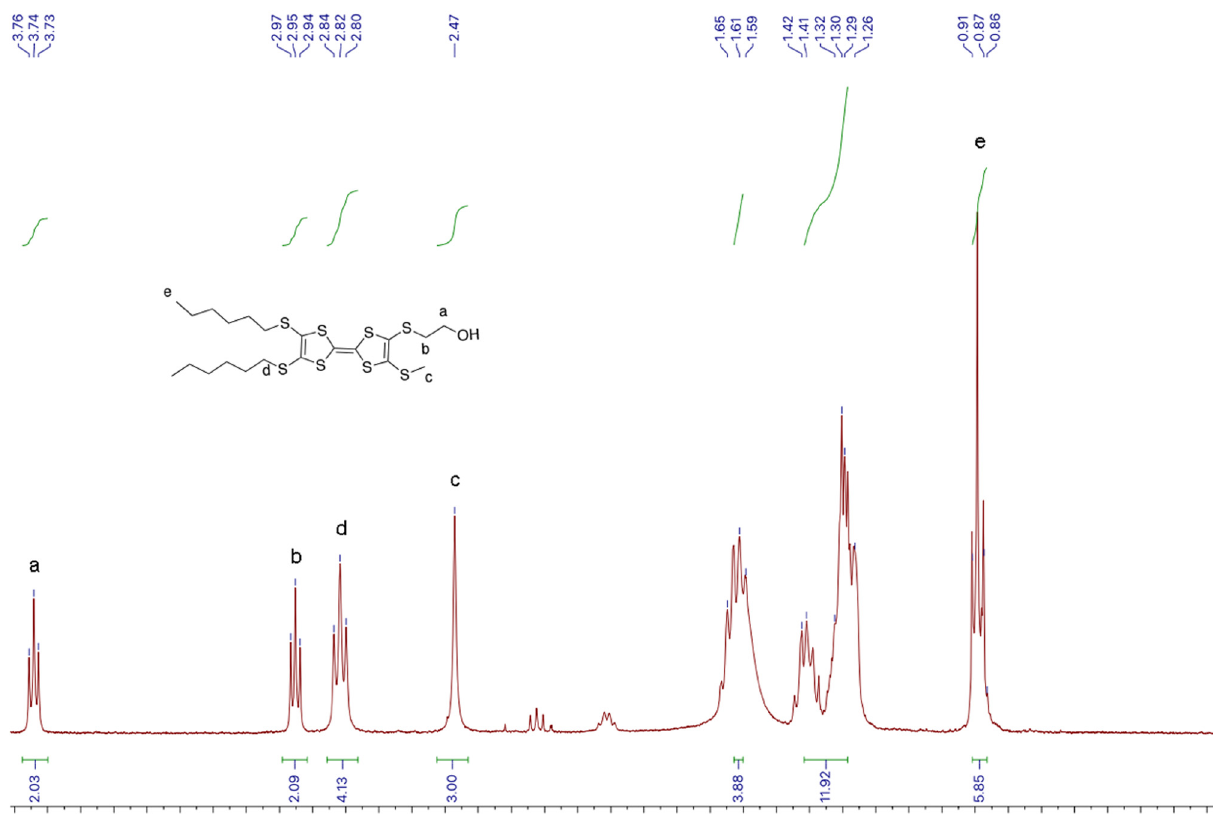
Figure A1: 1 H NMR of TTF -